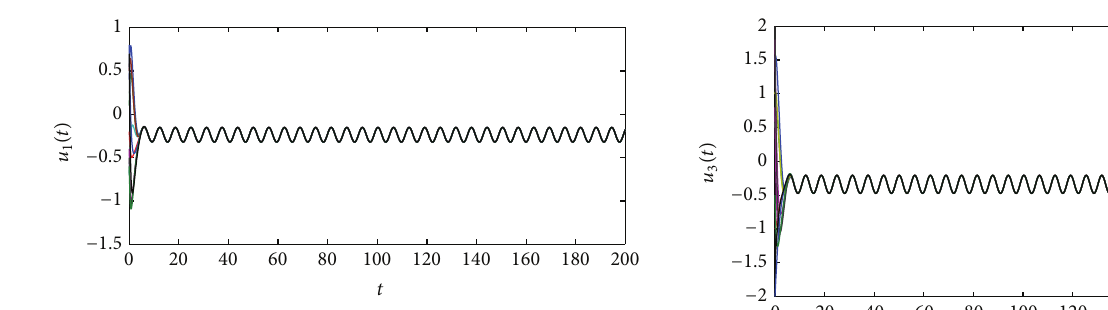
Figure 7: Transient response of state variables 𝑢 1 (𝑡) of Example 2.